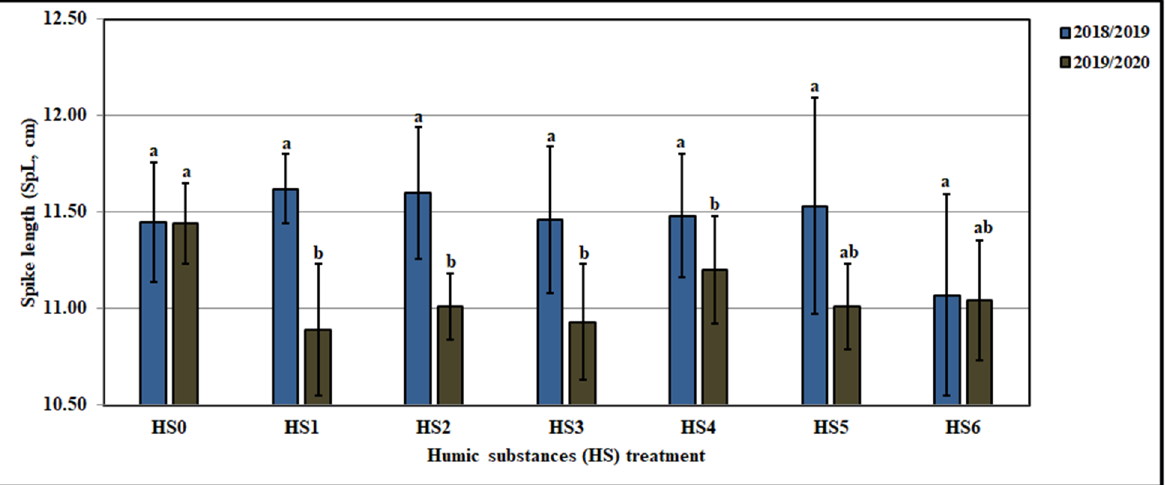
Figure 7. Influence of humic substances treatments on spike length (SpL, cm) of some wheat varieties grown in clay loam soil in 2018/2019 and 2019/2020 seasons. Bars in the same years with a different letter indicate significant differences between treatments at p ≤ 0.01. HS 1, HS 2 , HS 3 represent HS applied as foliar spray at 1.0, 2.0, 4.0 g L − 1 , respectively, HS 4 , HS 5 , HS 6 represent HS applied as soil application at 5.04, 7.56, 10.08 kg ha − 1 .